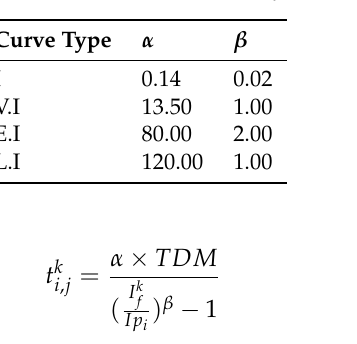
Table 1. Constants for the IEC relay